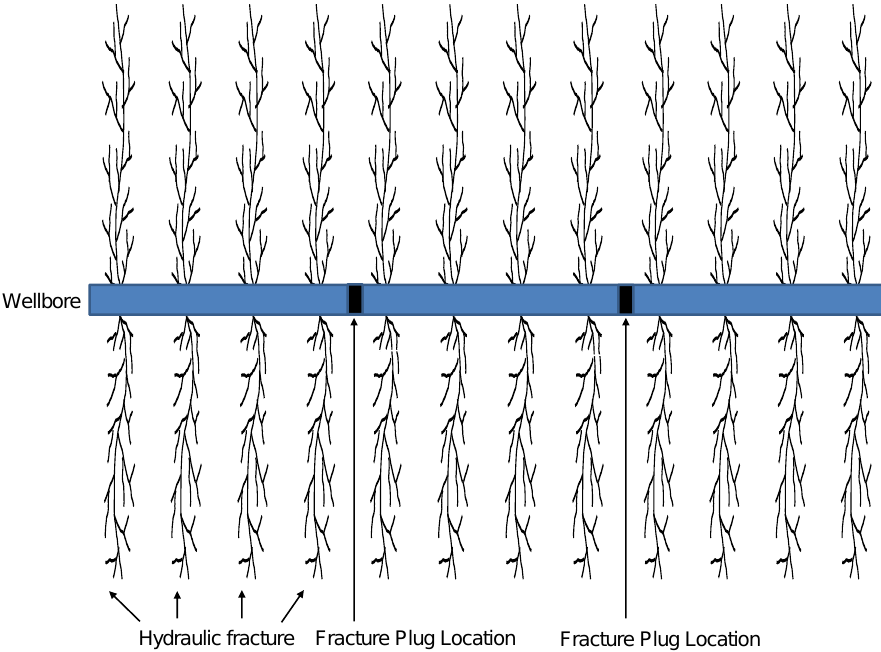
Figure 1. Twelve hydraulic fractures developed from 12 perforation clusters in three stages of fracturing.